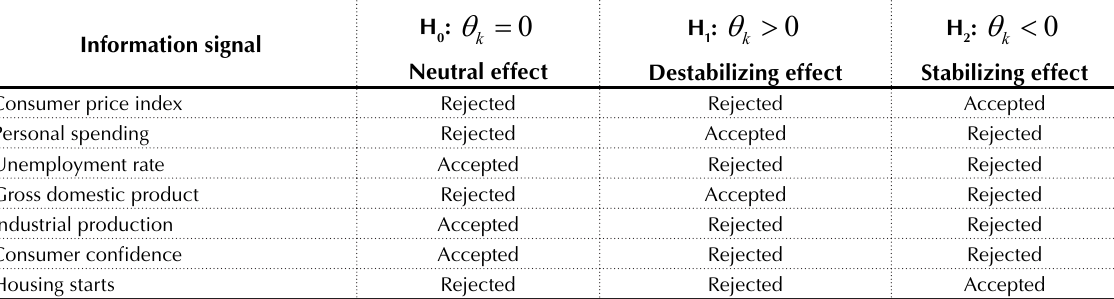
Table 6. The results of testing the hypotheses H component of the “surprise” of non-monetary information signals on stock quotes of enterprises of the economic sector “Oil &